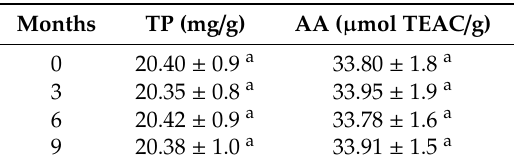
Table 1. Total phenol (TP) content and antioxidant activity (AA) of the unripe grape (UG) extract during storage. The data are the mean of three replicates ± standard deviation. The superscript letter indicates that no significant di ff erences were observed ( p >